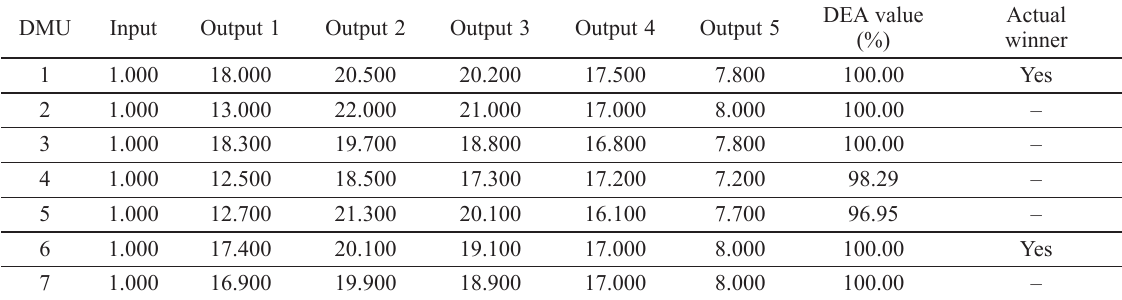
Table 5. Actual evaluation data of case project 3 Criteria (Weight) bidder